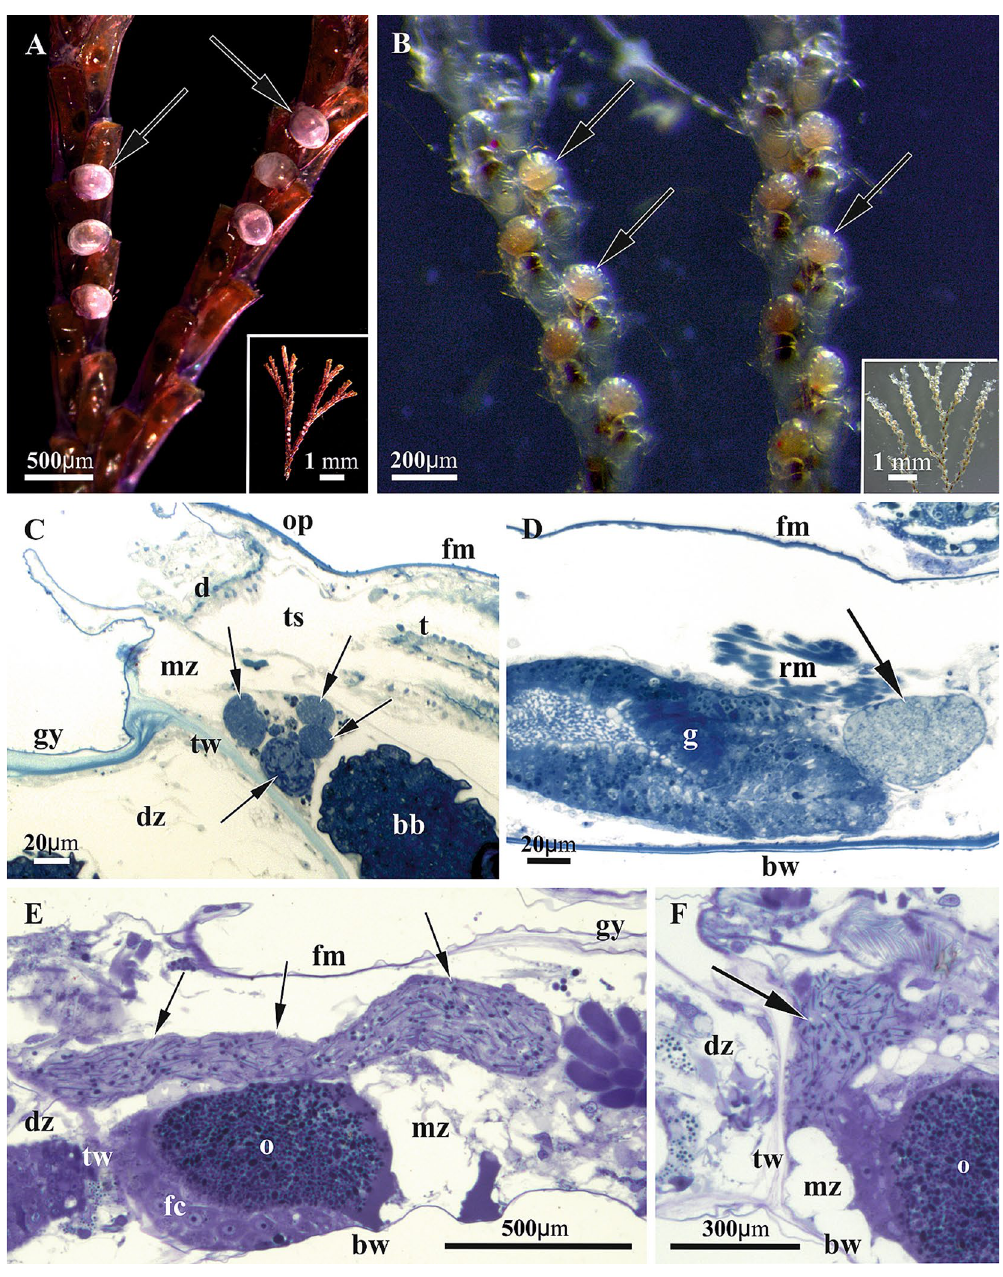
Figure 1. ( A , B) General view of colony branches of Bugula neritina ( A , insert) and Paralicornia sinuosa ( B , insert) (brood chambers (ovicells) with embryos shown by arrows). Stereomicroscope. ( C – F ), histological sections of autozooids of B. neritina ( C , D ) containing bacteria inside funicular bodies, and of P. sinuosa ( E , F ) with symbionts filling funicular cords (shown by arrows in both cases). Paracrystalline structures are visible as black ‘dots’ and ‘lines’ inside funicular cords in ( E , F ). Light microscopy. Abbreviations: bb, brown body (degenerated polypide); bw, basal wall; d, diaphragm; dz, distal zooid; fc, follicle cells; fm, frontal membrane; g, gut; gy, gymnocyst; mz, maternal zooid; o, oocyte inside ovary; op, operculum; t, tentacles of retracted polypide; ts, tentacle sheath; tw , transverse